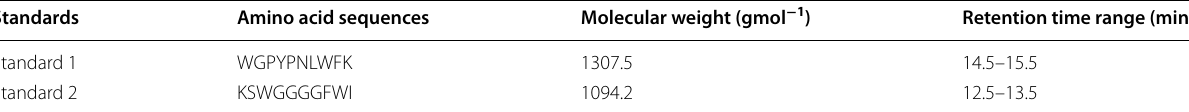
Table 3 Oligopeptide molecules used as standard samples in HPLC